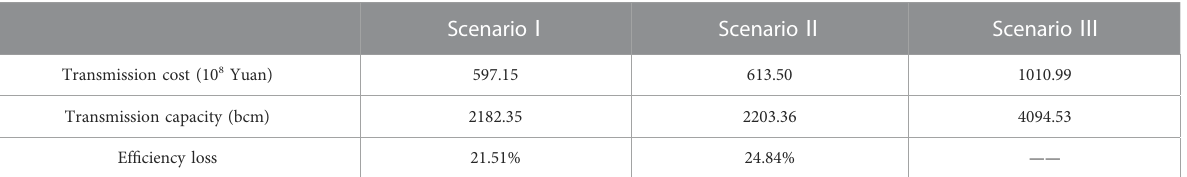
TABLE 3 The results of the three Scenario Ⅰ , Ⅱ , and Ⅲ